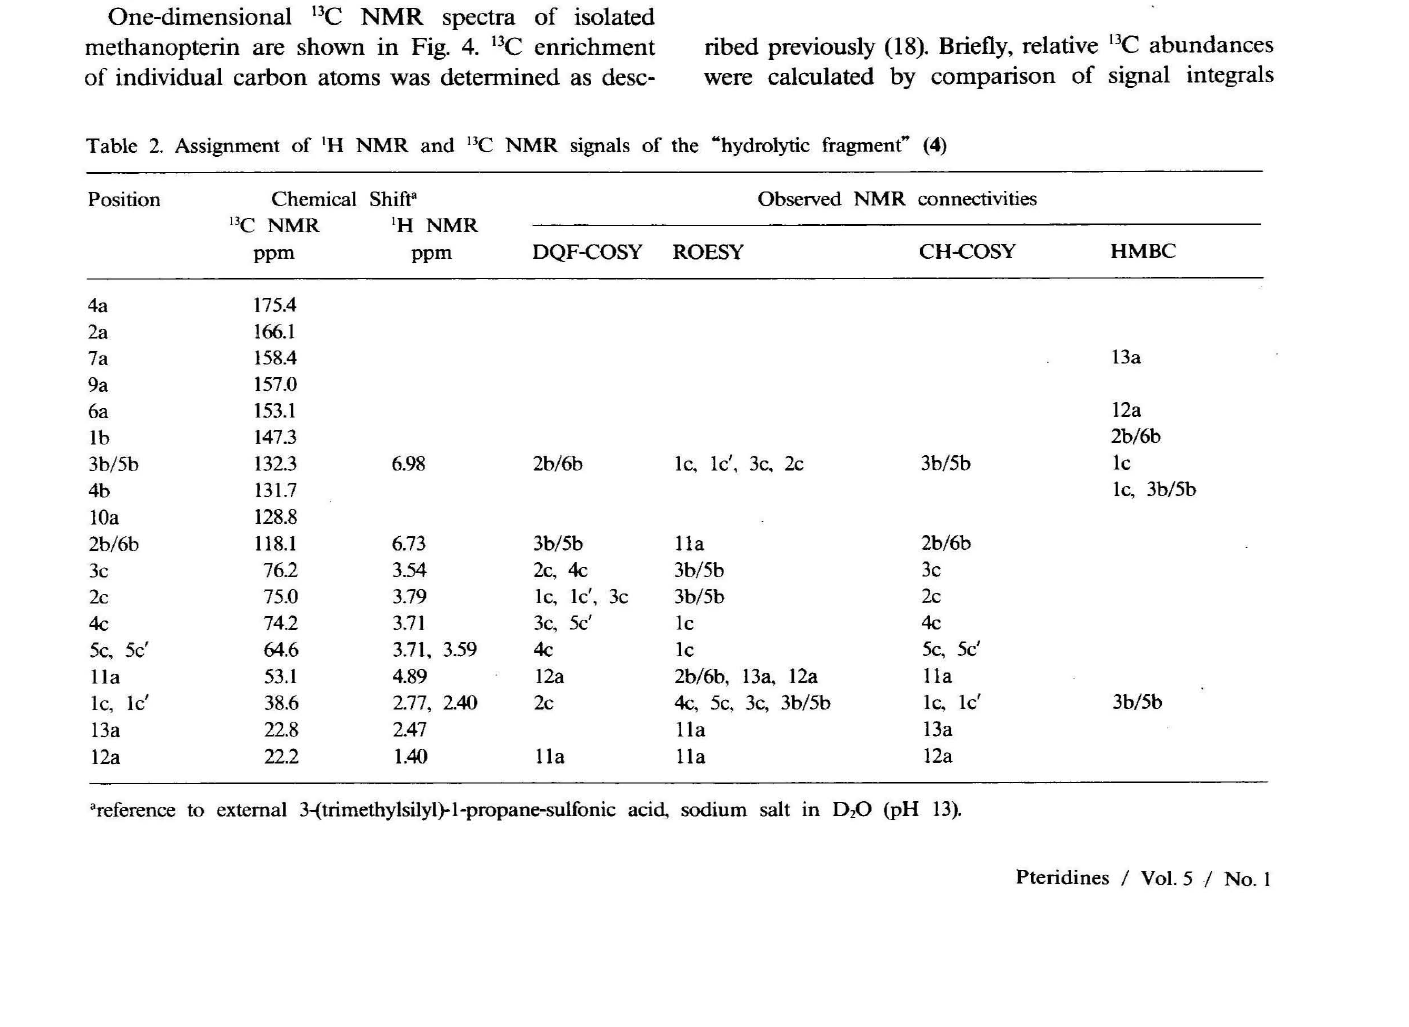
Figure 4. 13C NMR spectra of methanopterin. a, natural i3C abundance; from growth experiment with b, [l_13C]acetate; c, [2-1lC]acetate; d, [1,2-i3C 2 ]acetate. ribed previously (18). Briefly, relative 13C abundances were calculated by comparison of signal integrals